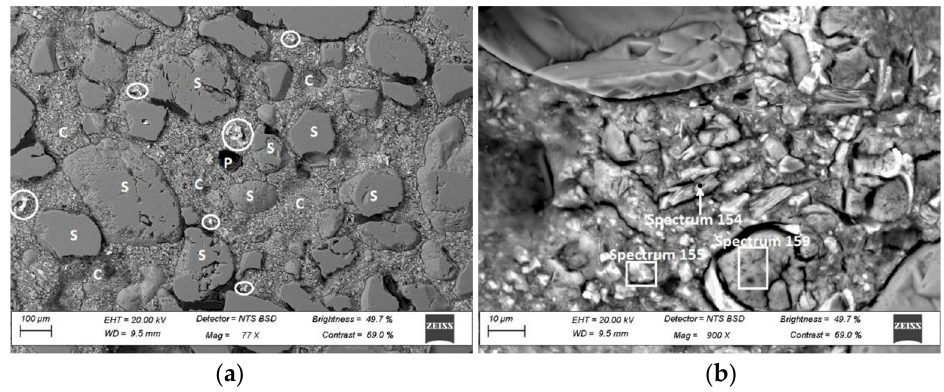
Figure 11. ( a ) SEM image showing the different particles in the MFN mortar, ( b ) Electron image showing analysed EDS spectrums 154, 155, and 159.